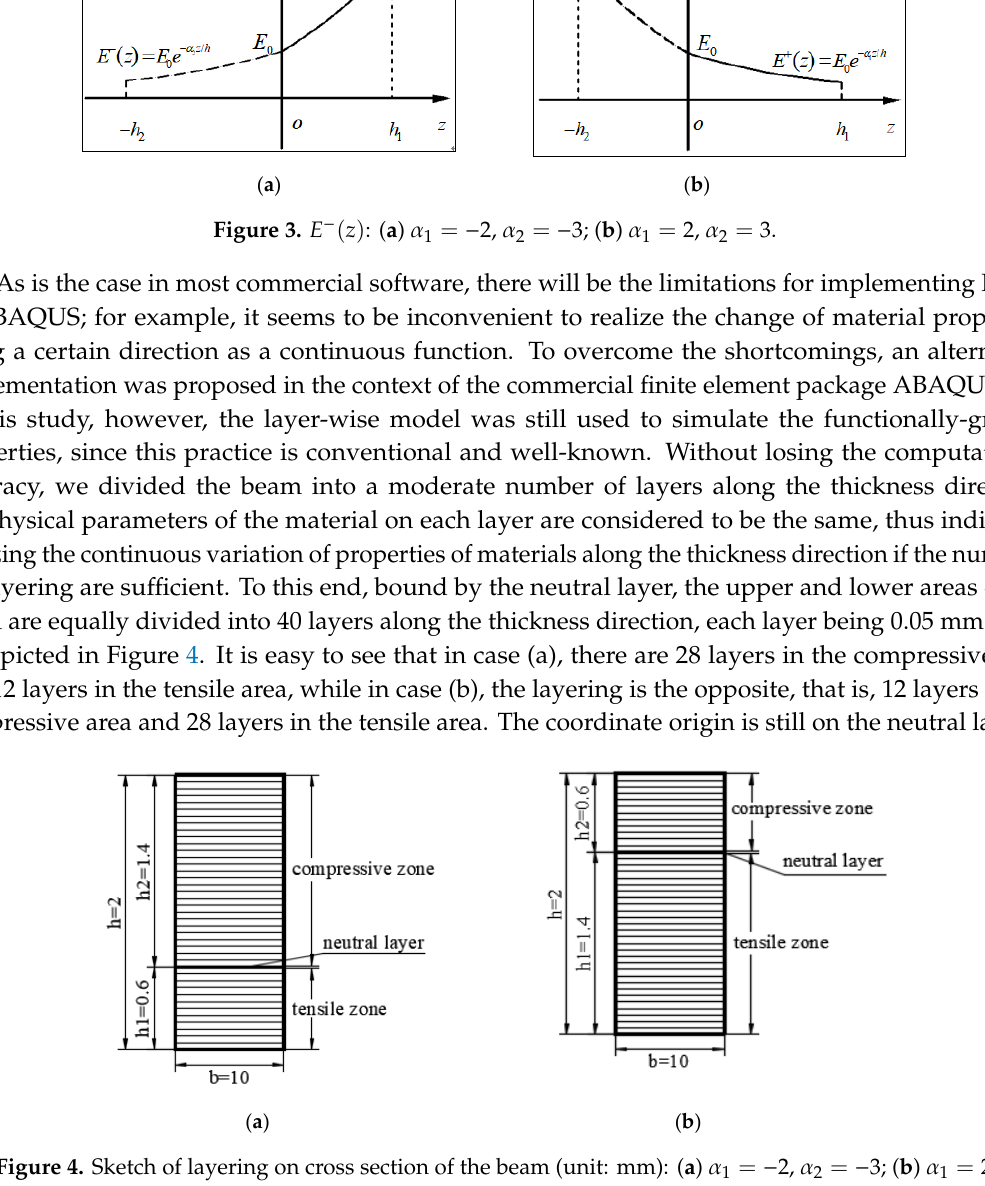
Figure 4. Sketch of layering on cross section of the beam (unit: mm): ( a ) α 1 = − 2, α 2 = − 3; ( b ) α 1 = 2, 2 , 3 . α = 1 2 2